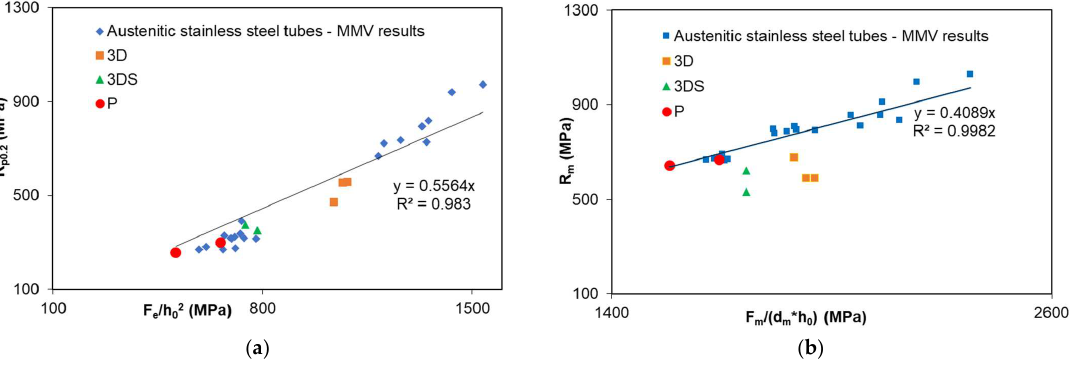
Figure 4. Correlation of SPT and standard tensile test data for austenitic steels the results present: ( a ) yield point, ( b ) tensile strength.